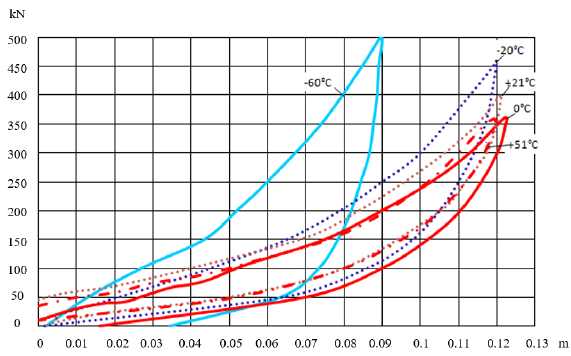
Figure 3. Static force–deformation curve of the polymer block of PMKP-110 buffer as f ( T °C).